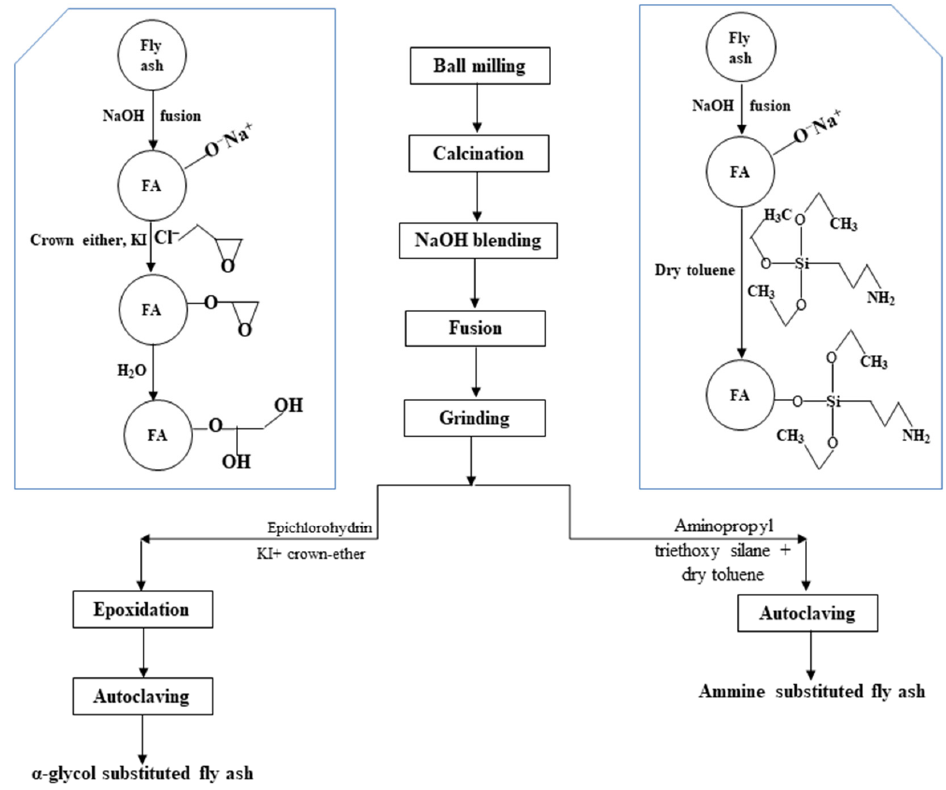
Figure 11. Novel functionalization of coal fly ash to replace the API-grade bentonite as drilling fluid additive [160].